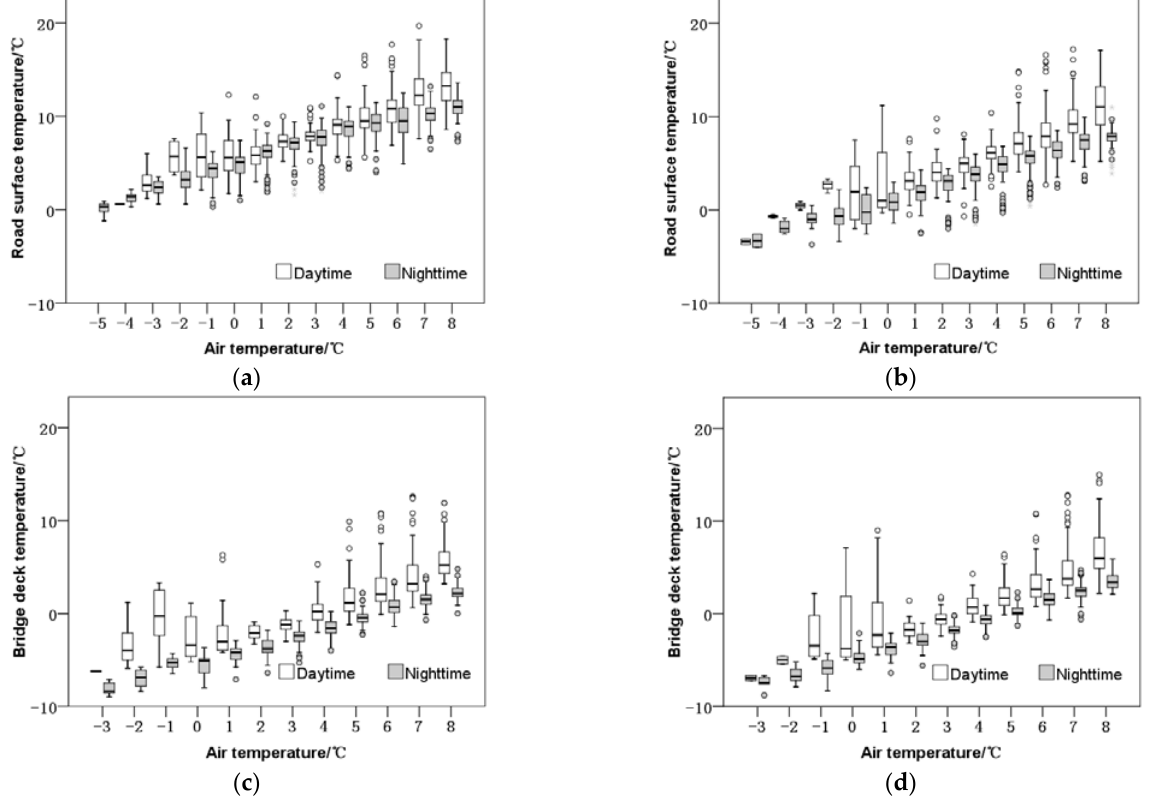
Figure 3. Box diagram of air temperature against surface temperature at road surface station 1 ( a ), road surface station 2 ( b ), bridge deck station 1 ( c ), bridge deck station 2 ( d ). (White box is for daytime; gray box is for nighttime. The abscissa value represents a range of ±0.5 °C.)